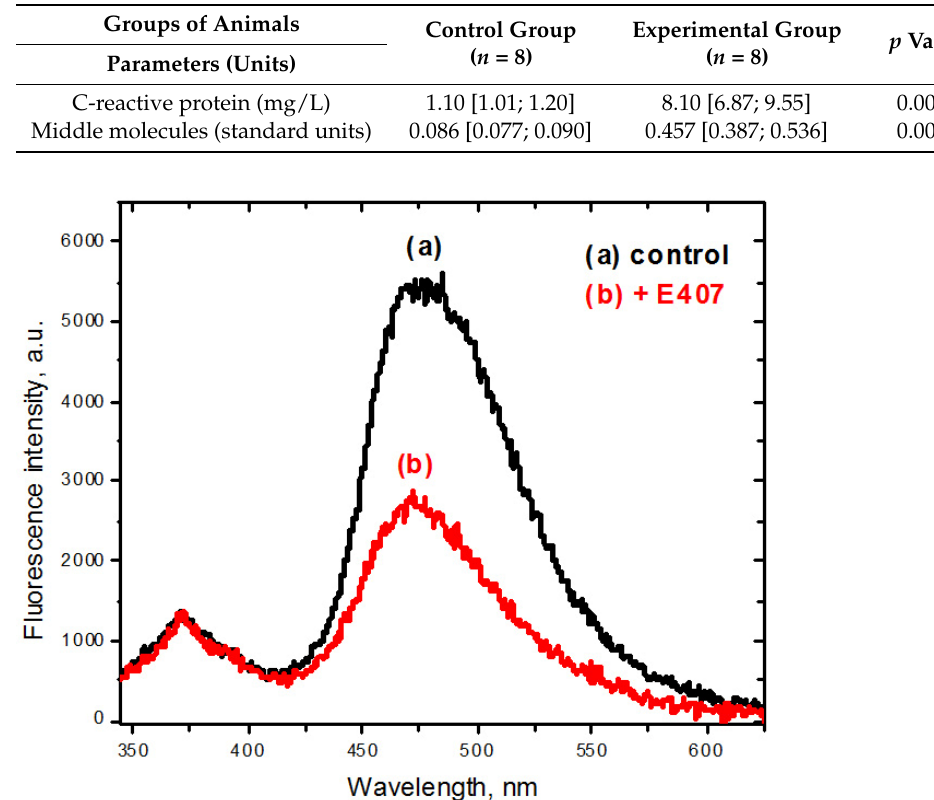
Table 1. Circulating inflammatory biomarkers in rats orally exposed to the common food additive E407a (Me [IQR]).